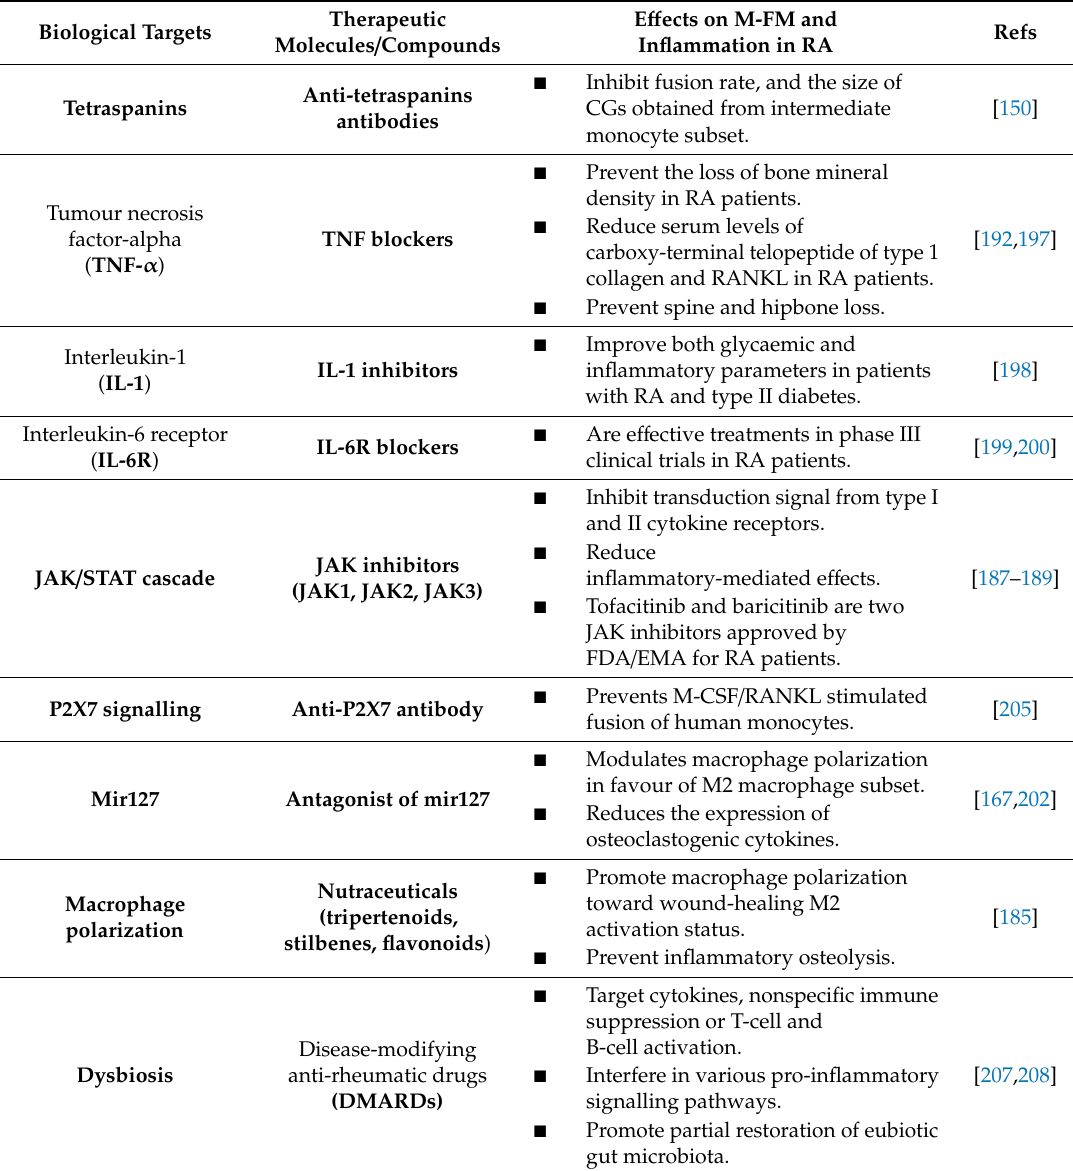
Table 4. Perspectives for rheumatoid arthritis (RA) therapy: biological targets for inhibiting inflammation and monocyte / macrophage fusion and multinucleation (M-FM) in osteoclasts (OCs) and giant cells